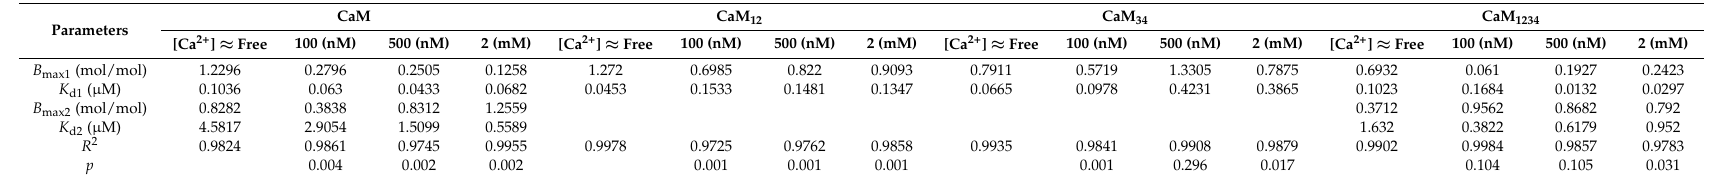
Table 1. Parameters for the bindings of CaM and its mutants to Na V 1.1 IQ